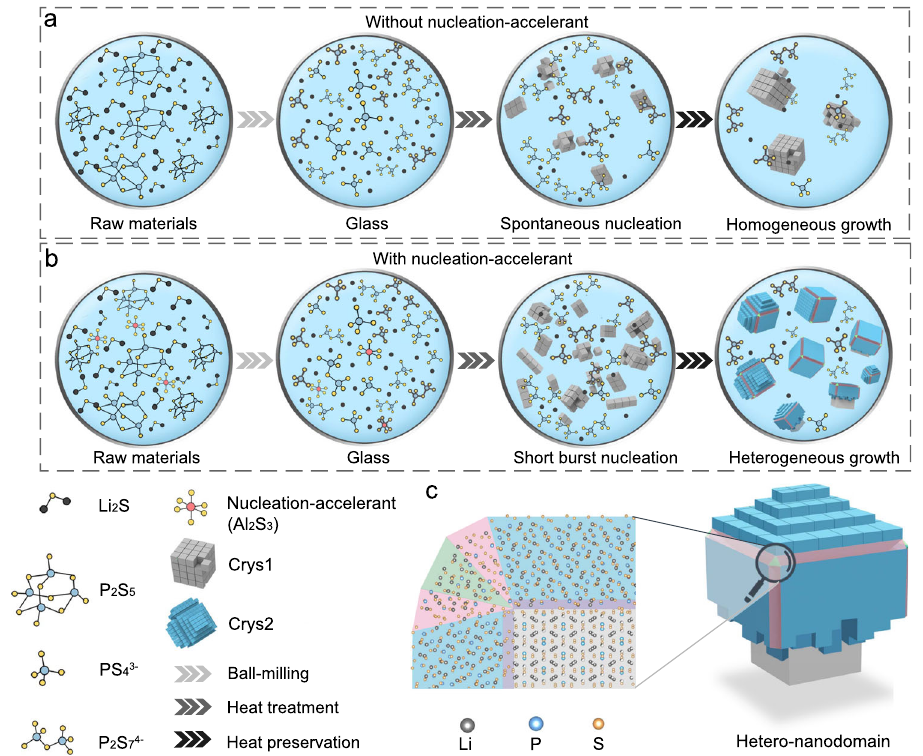
Fig. 1 | Schematic illustration of the sequential crystallization and hetero- geneousgrowthmodel(mechanism). GC ’ scrystallization( a )withoutand( b )with nucleation-accelerant. c A schematic diagram of 3-dimentional and